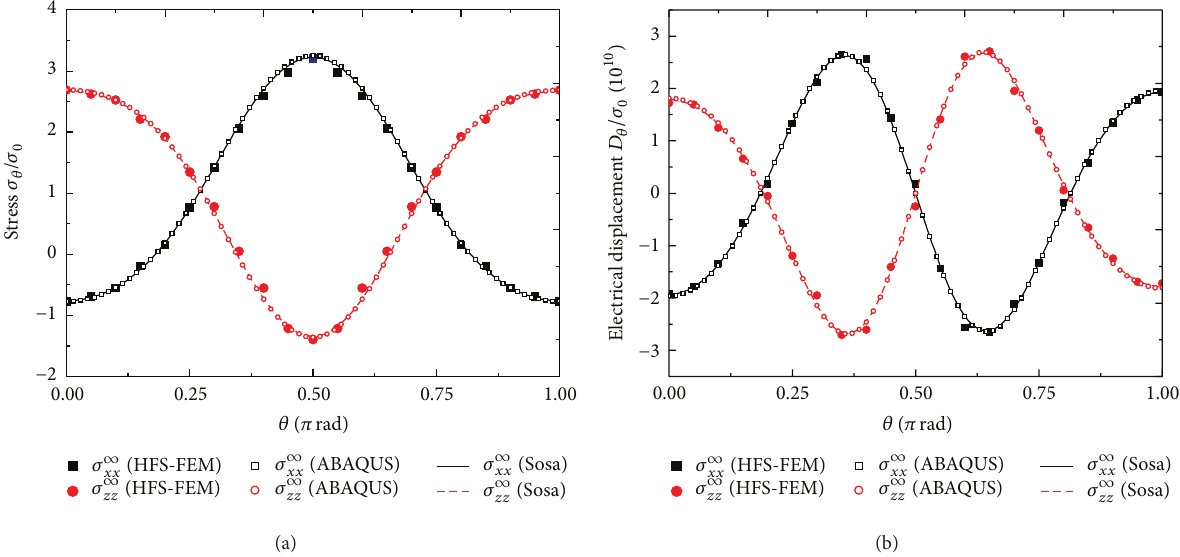
Figure 25: Variation of (a) normalized stress 𝜎 𝜃 /𝜎 0 and (b) electrical displacement 𝐷 𝜃 /𝜎 0 × 10 10 along the hole boundary under remote mechanical